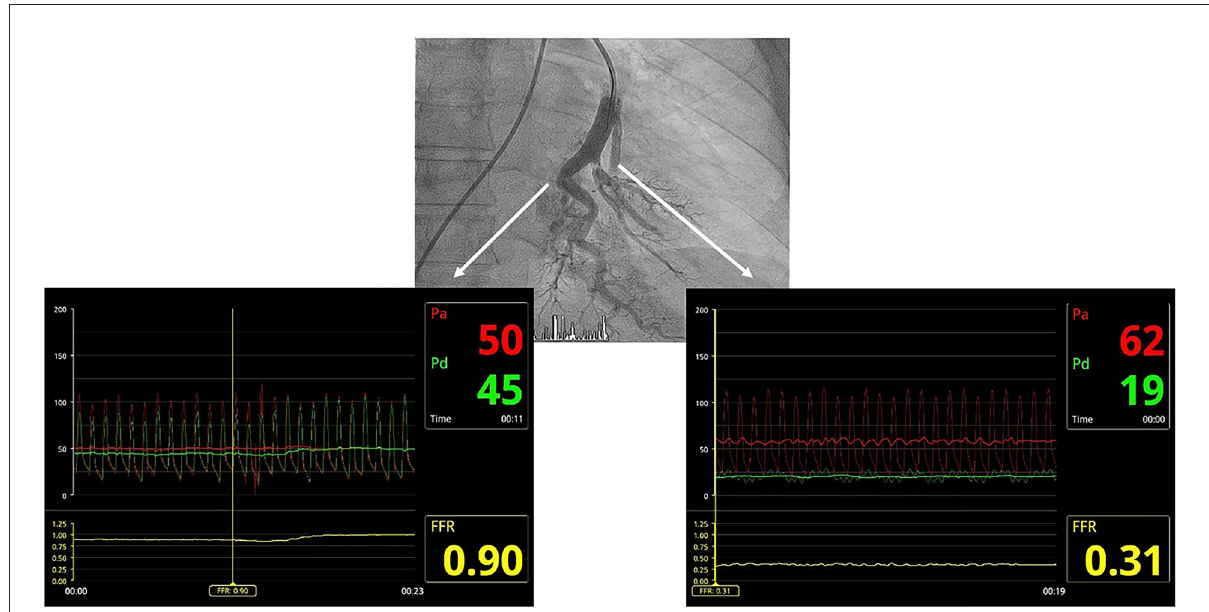
FIGURE1 Utility of the pressure wire in clarifying angiographic images corresponding to arterial branch bends or true webs. The radiolucent image in the segmental branch on the left of the composition corresponds to an artery loop, with no significant pressure gradient between the guide catheter and the pressure wire distal to the lesion. The radiolucent image in the segmental branch on the right corresponds to a real web, with a significant pressure gradient between the guiding catheter and the pressure wire distal to the lesion, which is significantly